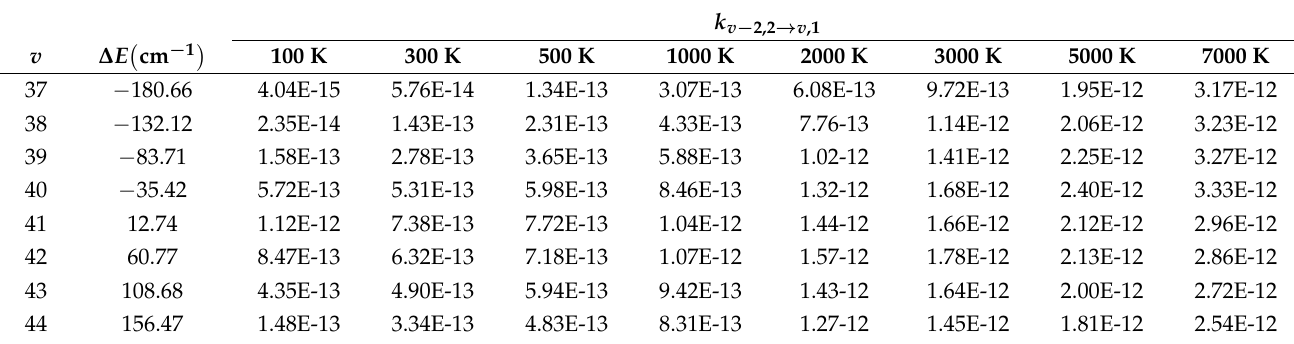
Table 7. V–V rate coefficients (in cm 3 /s) for the near-resonant asymmetric transition CO ( v − 2 ) + N 2 ( 2 ) → CO ( v ) + N 2 ( 1 ) + ∆ E